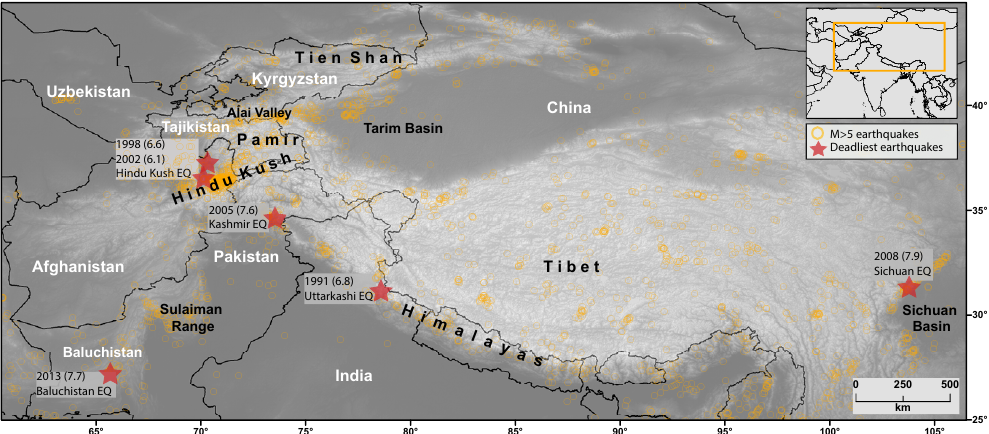
Figure 1. Map of the study area showing M ≥ 5 earthquakes (orange circles) for the 1900–2014 period from ANSS Comcat (2014). Red stars mark the location of the deadliest earthquakes for the 1900–2014 period that are discussed in the text. The only exception is the 2001 M 7.7 Bhuj earthquake which is located outside the study area, but it is still considered to be within the India–Eurasia collision zone.